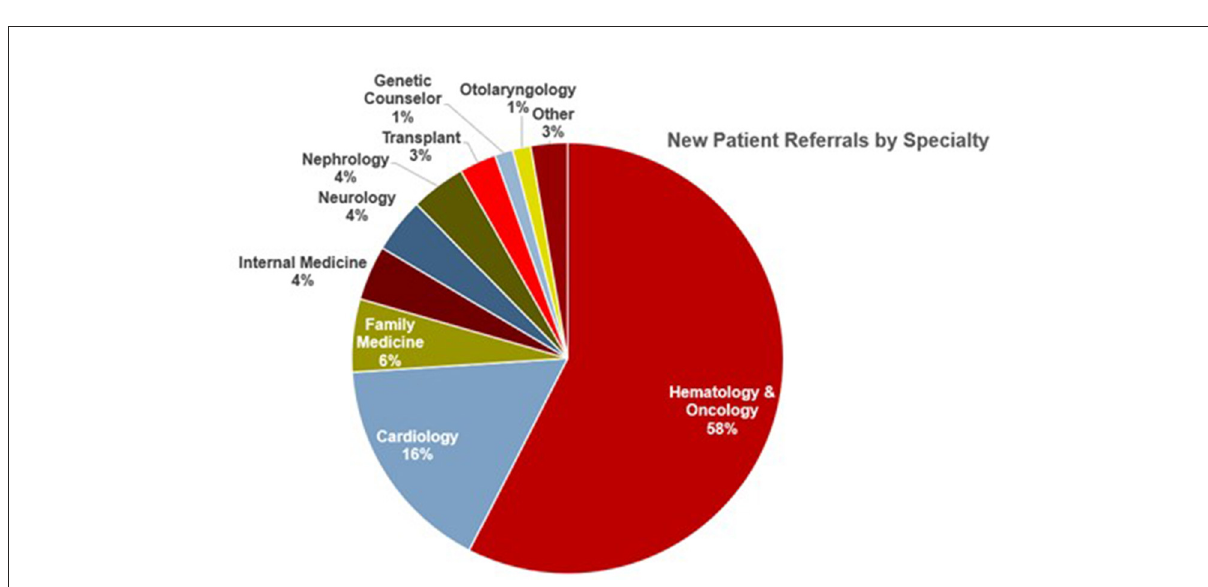
FIGURE5 Source of referrals to the Ohio State University Comprehensive Amyloidosis Clinic, arranged by